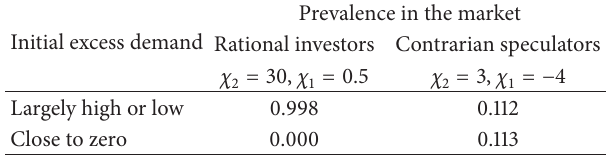
Table 3: Correlation between the returns of high-risk and low-risk assets estimated by rational agents (ex-ante correlation).